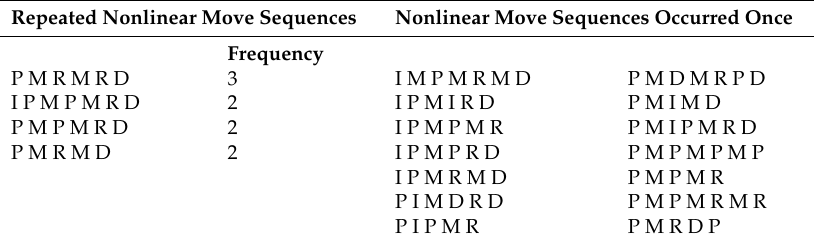
Table 6. Frequencies of 23 non-linear move